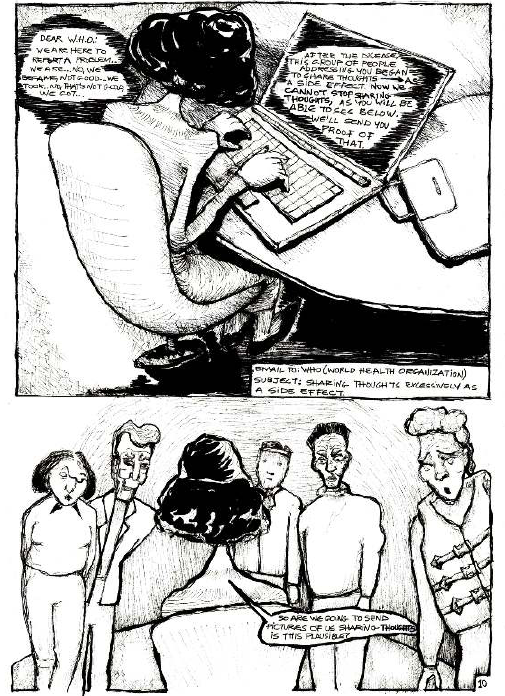
Figure 11: Plate 10, Diamond Princess II